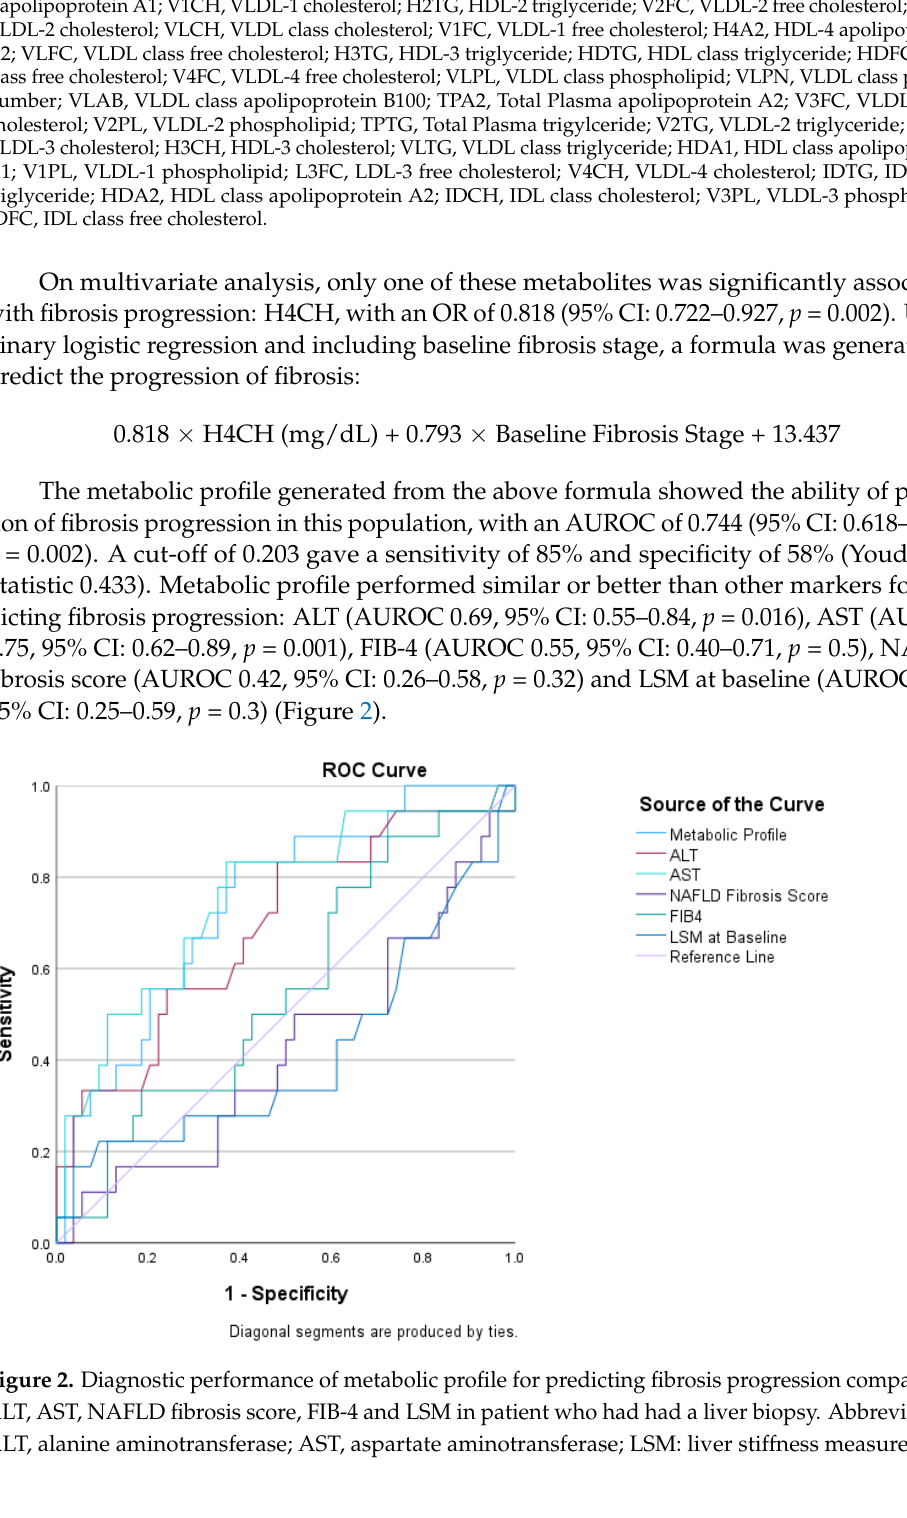
Table 5. Differences in metabolic profile between cirrhotic and noncirrhotic patients. Metabolite